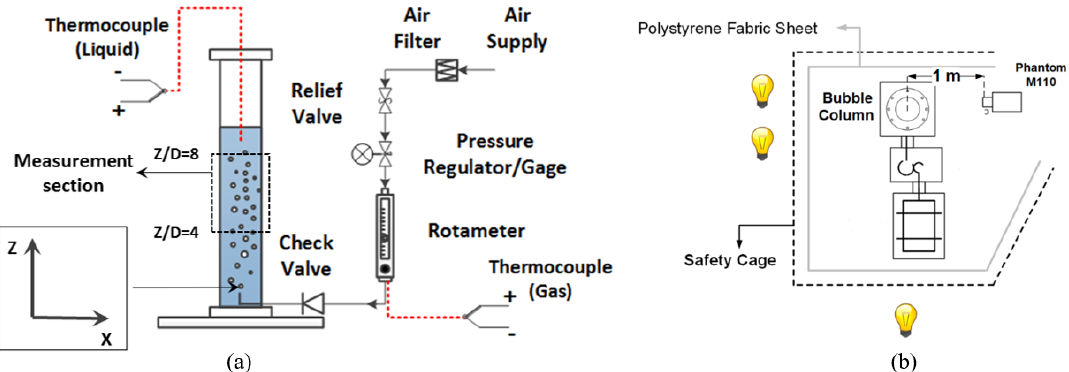
Figure 1. ( a ) Schematic of the experimental setup including the bubble column, gas injection system and instrumentation to monitor and control flowrates. ( b ) Top view of the column showing the camera and lighting configuration for bubble imaging.